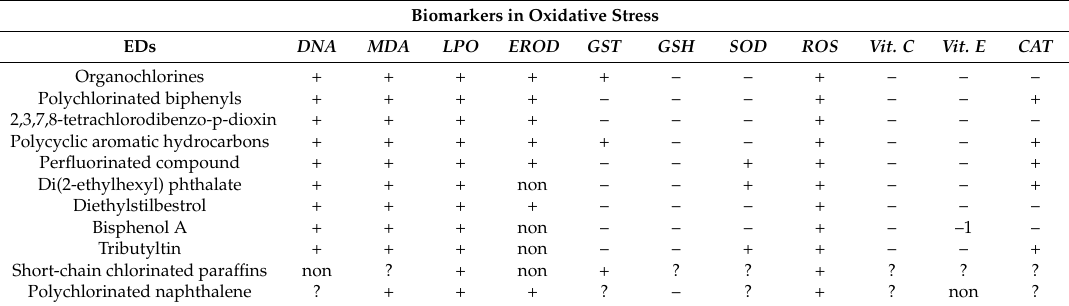
Table 3. Categorization of oxidative stress biomarkers according to endocrine disruptor